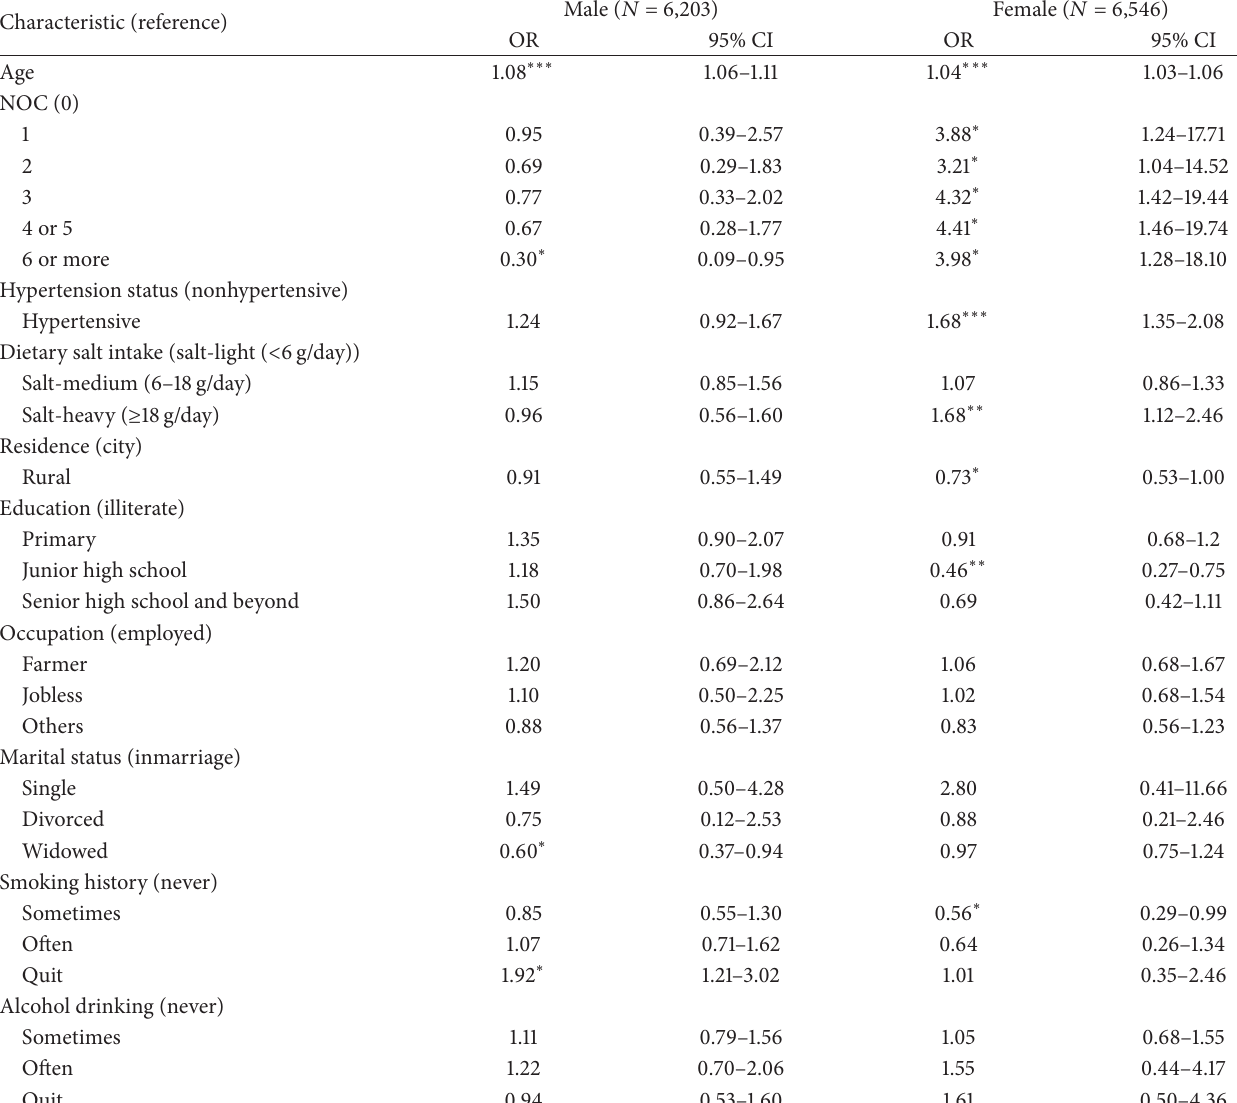
Table 2: Odds ratio (OR) with 95% confidence intervals (CIs) of gender-specific logistic regressions for nondiabetic